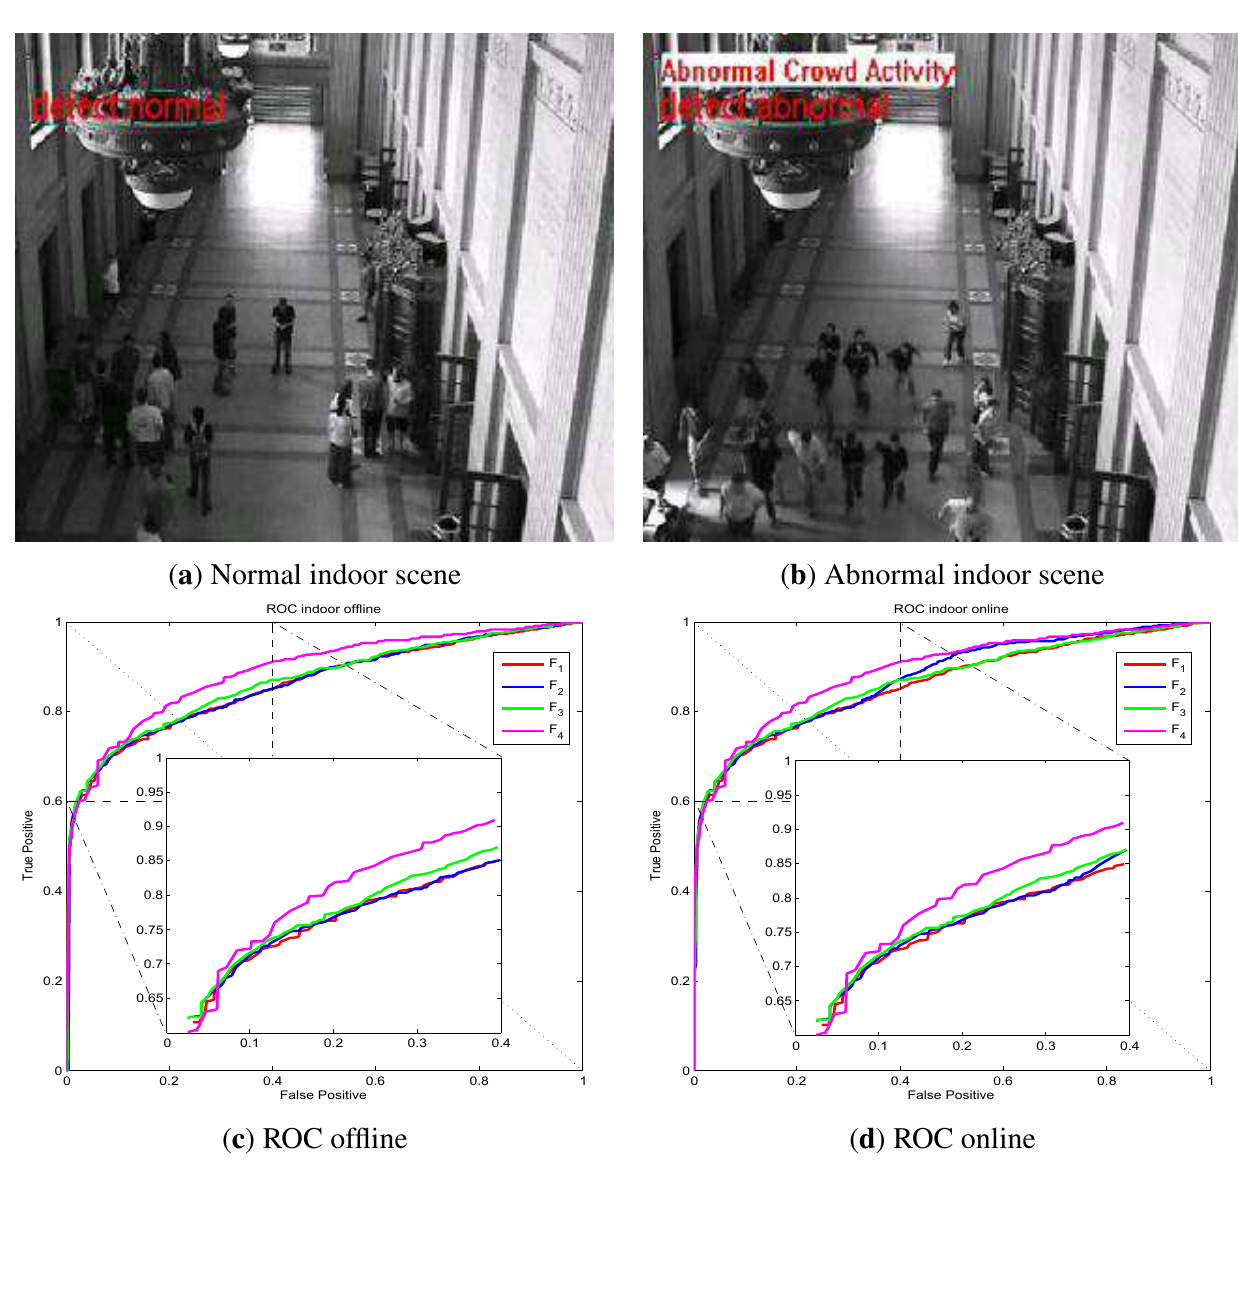
Figure 8. Detection results of the indoor scene. ( a ) The detection result of a normal frame; ( b ) The detection result of an abnormal panic frame; ( c ) ROC curve of covariance descriptors constructed from different features F of the indoor scene results via LS-OC-SVM. All the training samples are learned together offline. The biggest AUC value is 0.8900; ( d ) ROC curve of detection results via online LS-OC-SVM. The biggest AUC value is